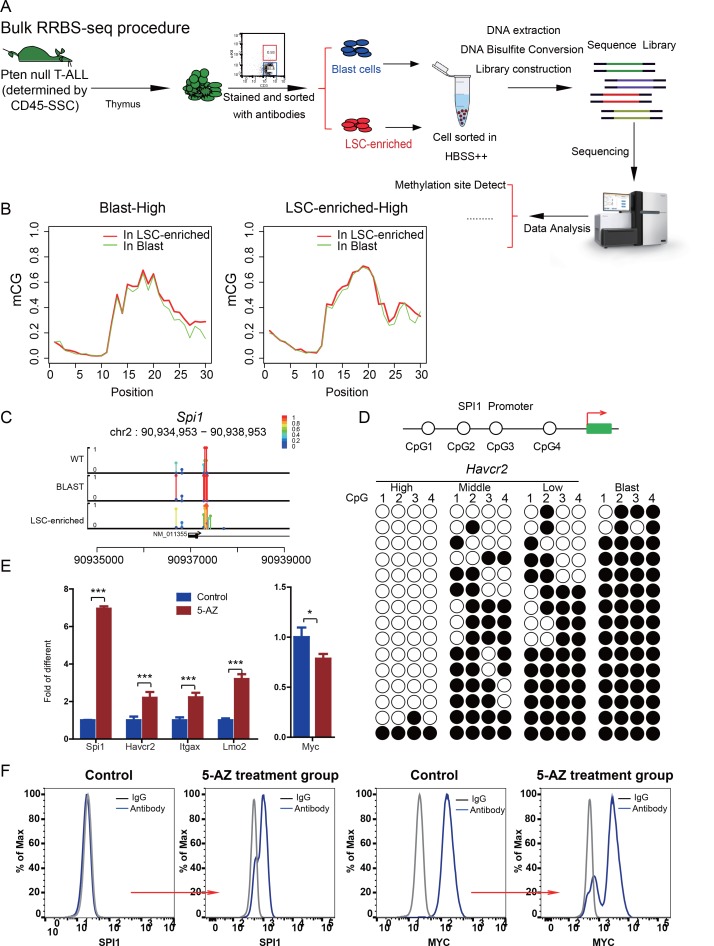
Spi1 expression is controlled by DNA methylation(A) Schematic illustrating the procedures involved in cell isolation and RRBS analysis; (B) DNA methylation status of genes specifically expressed in the leukemic blast (left) and LSC-enriched (right) subpopulations; (C) Spi1 promoter methylation status in normal T cells, LSC-enriched cells and blast-enriched cells.